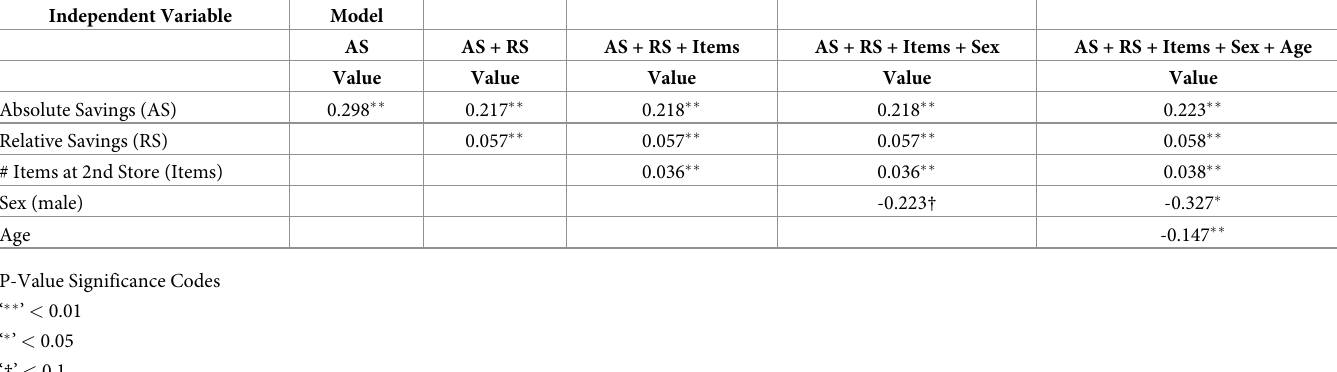
Table 5. Ordered Logistic Regression results against likelihood (n = 808) (Study 1).